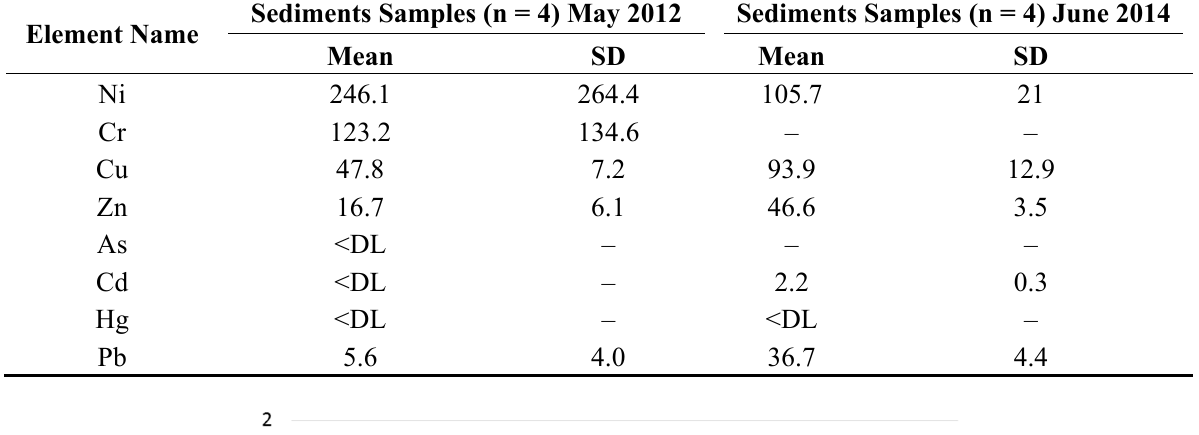
Table 4. Mean values in mg kg − 1 and standard deviation (SD) of heavy metals of sediment in Kouris reservoir (DL-Detection Level).